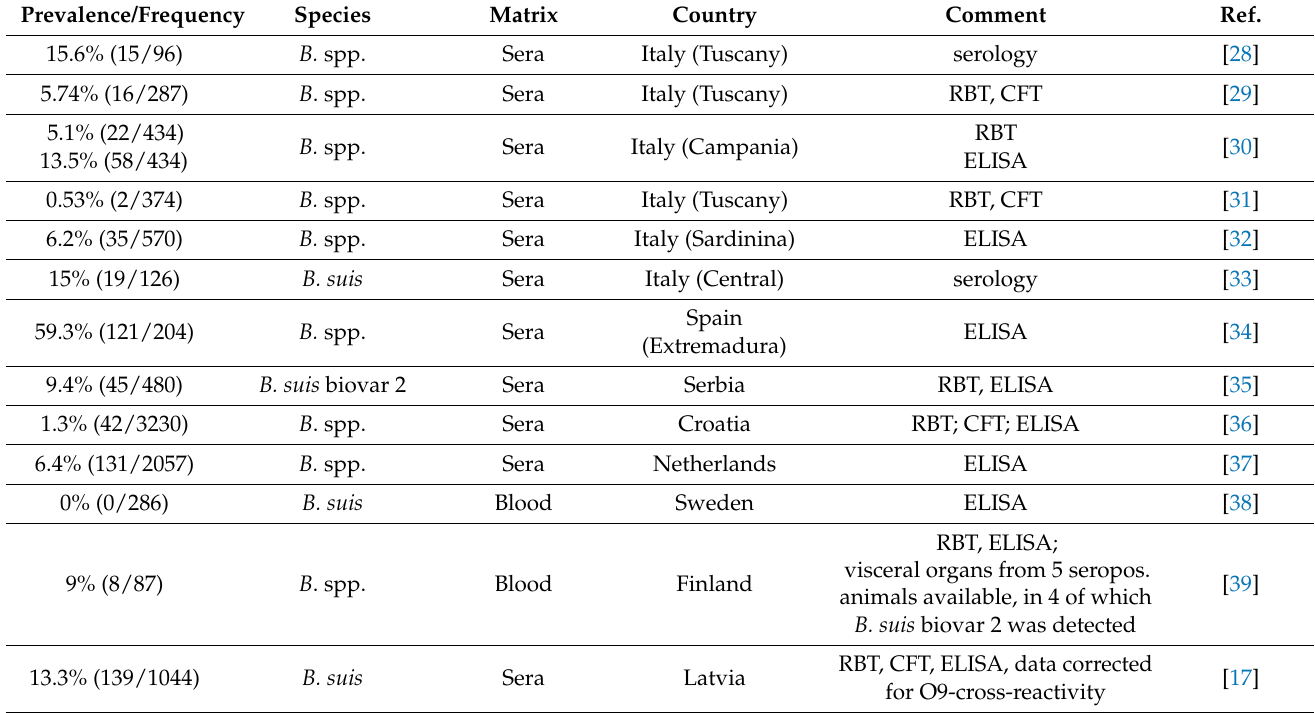
Table 2. Prevalence of Brucella spp. antibodies in wild boars (2012–2022), by country and continent. Prevalence/Frequency Species Matrix Country Comment